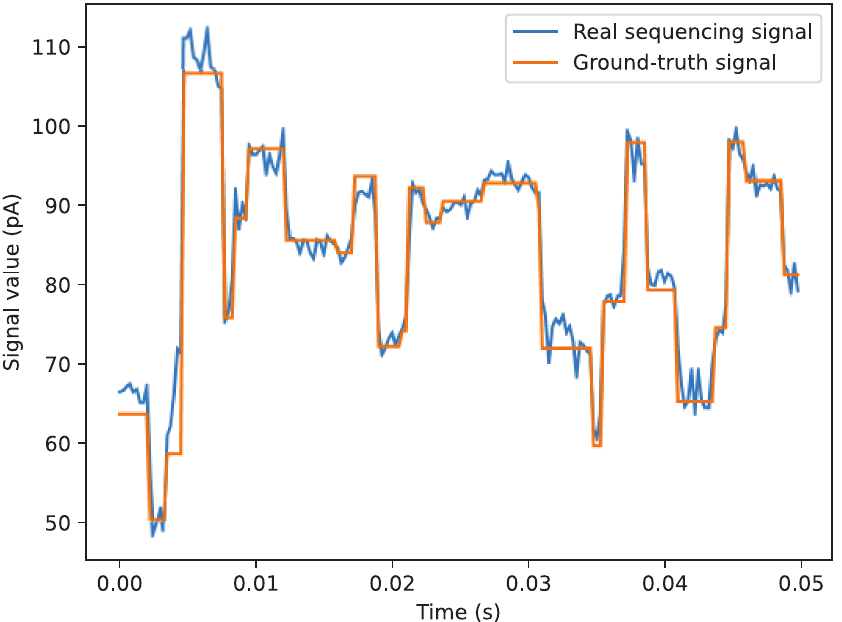
Figure 5. The supervised training data of signal processing model, including the real sequencing signal and the corresponding ground-truth signal. The ground-truth signal is calculated by labeling the real sequencing